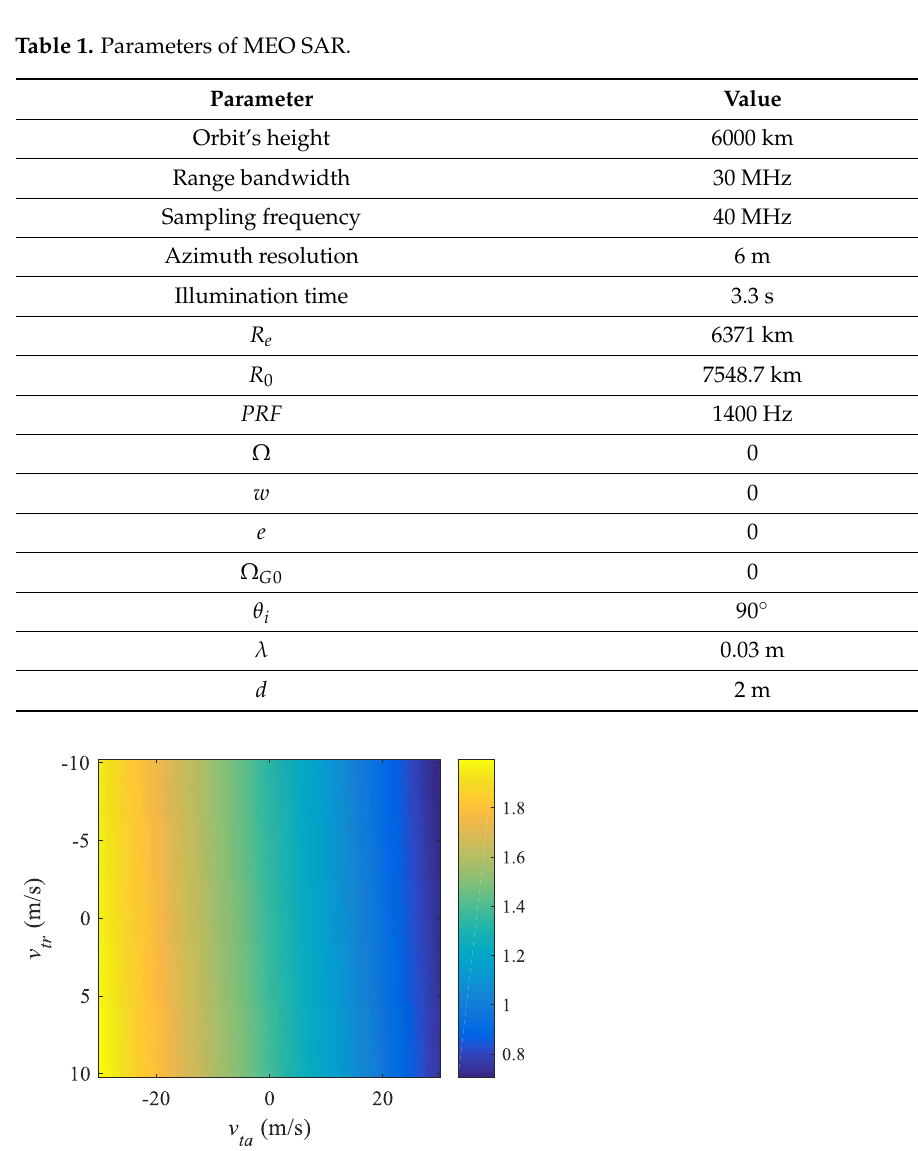
Figure 3. Residual RCM of the target with all possible velocities (i.e., v tr and v ta ). The color indicates the value of ∆ RCM max , and the unit is m . The distance between the target and the scene center is set to be 7568.7 km. The accelerations are 0.1 m/s 2 . Table 1. Parameters of MEO SAR.